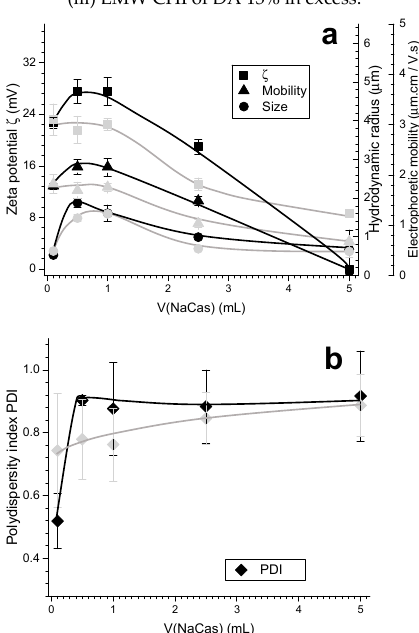
Figure 5. ( a ) Zeta potential ζ , electrophoretic mobility, hydrodynamic radius (size), and ( b ) polydispersity index PDI obtained for the experiment (iii) of the Case I (chitosan in excess): sodium caseinate added to LMW CHI of high DA = 13%. Black curves show the polyelectrolyte complex (PEC) characteristics obtained in the first week; grey curves show the results obtained after two weeks aging at room temperature.